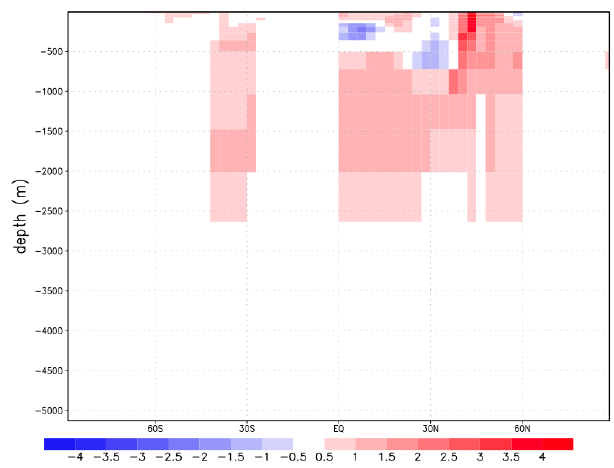
Figure 9. Depth section at 45 ◦ W of the difference in annual mean potential temperature ( ◦ C) at 134kyrBP, averaged over 100yr, be- tween allGR and fwfGR